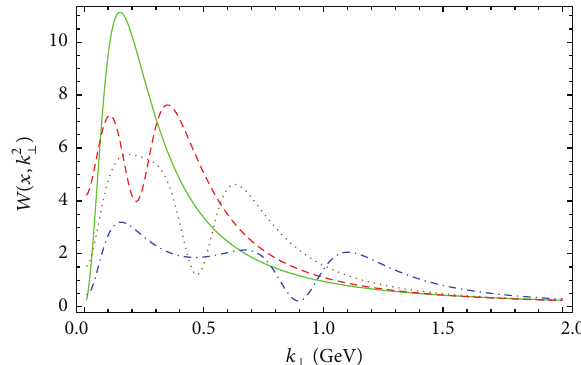
Figure 3: Variation of gluon spectrum 𝑊(𝑥, 𝑘 2 ⊥ ) off heavy quark ( Δ 𝑀 = 0.1 , 𝑥 = 0.1 ) with gluon transverse momentum for different extents of recoil of heavy quarks. Green (solid): 𝜁 = 0.0 ; red (dashed): 𝜁 = 0.15 ; brown (dotted): 𝜁 = 0.30 ; blue (dot-dashed): 𝜁 = 0.45 .